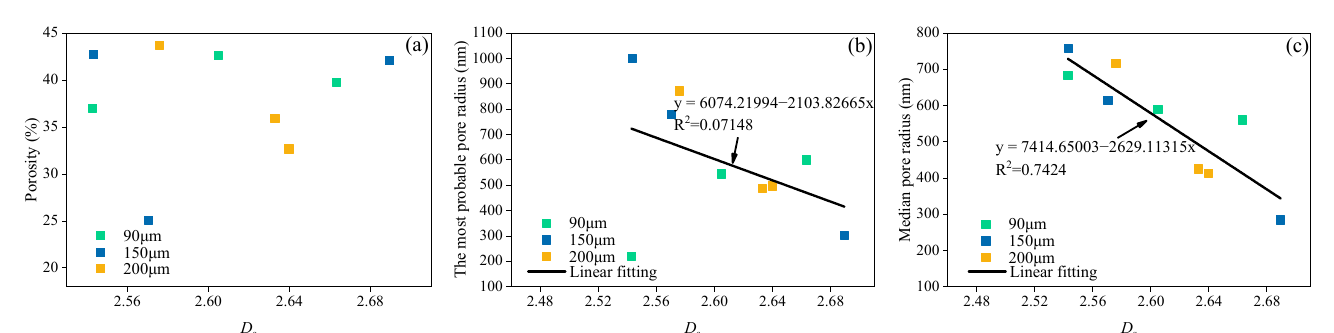
2.54 2.56 2.58 2.60 2.62 2.64 2.66 2.68 Figure 8. Relationship between D s and ( a ) porosity, ( b ) the most probable pore size, and ( c ) median pore radius for porous alumina samples with 30 vol.% pore-forming agents.